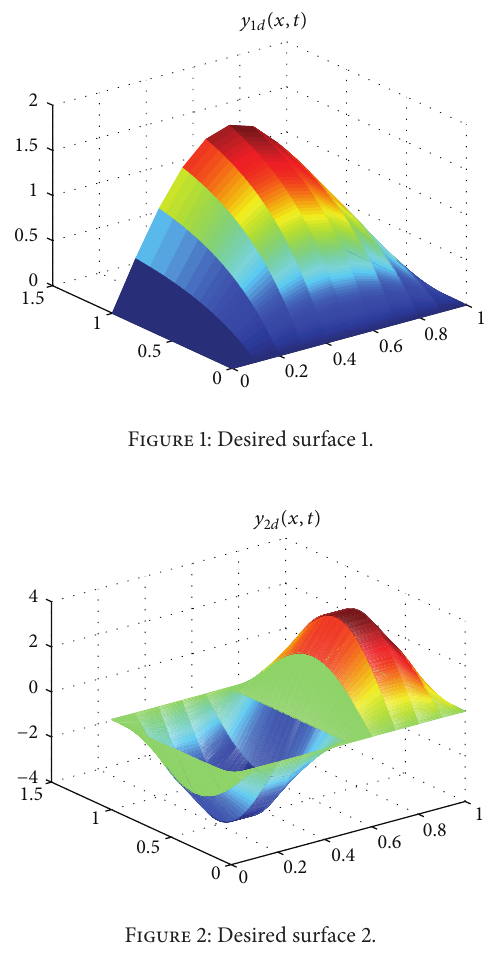
Figure 2: Desired surface